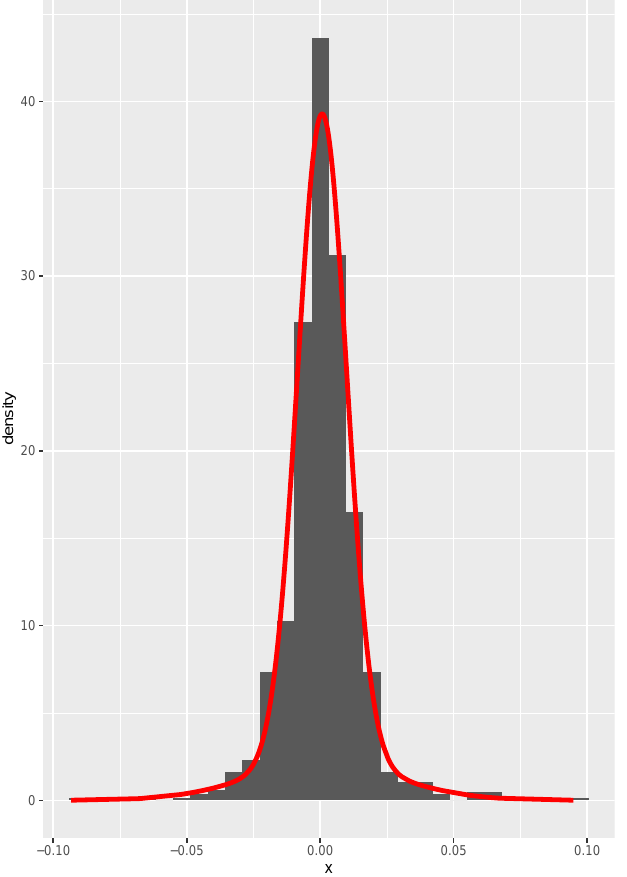
Figure 8. This figure represents the fitting of a Gaussian mixture on the return of the Tesla share. The EM is used here, considering the lower and upper truncations at, respectively, the maximum and the minimum values contained in the dataset and assuming a Gaussian distribution. Here, with respect to the Gaussian distribution, we obtained risk